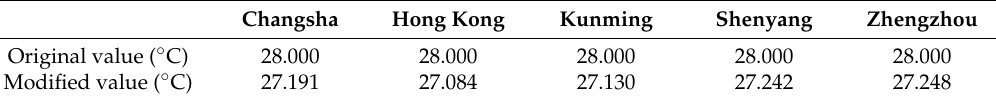
Table 6. Balance-point temperature in different